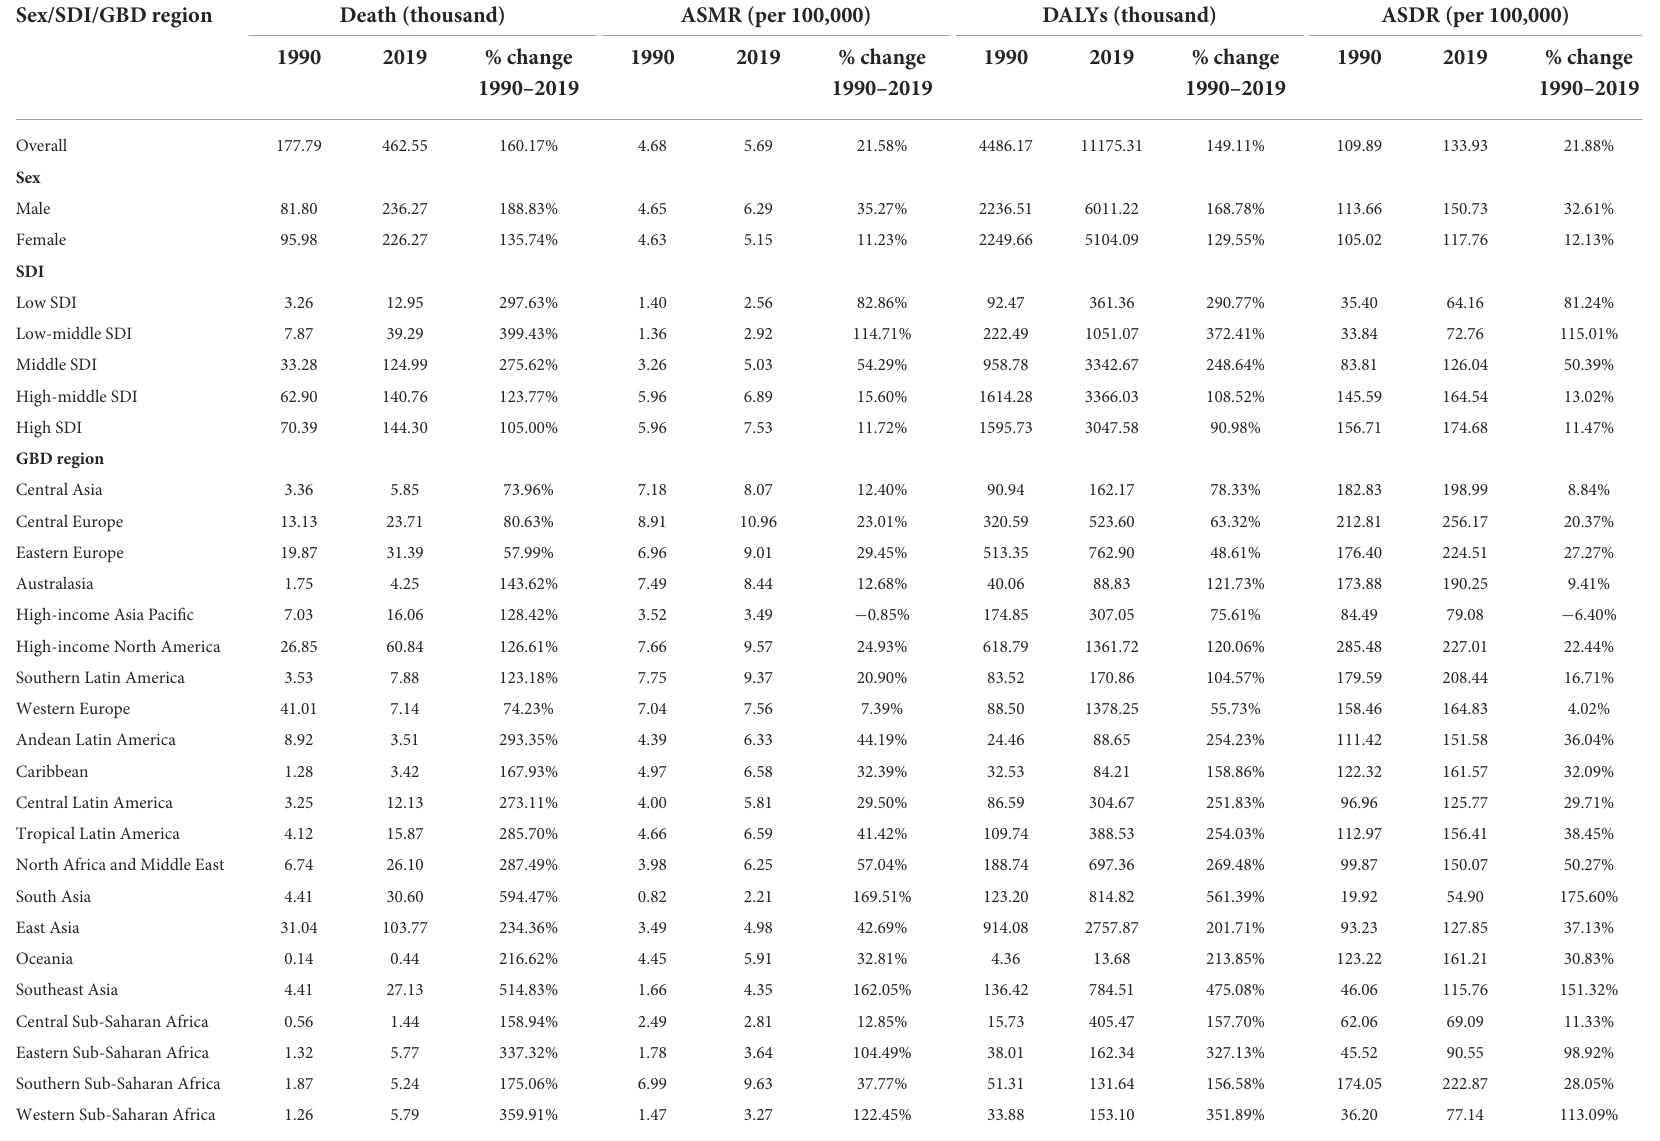
TABLE 1 Global deaths and DALYs of cancer attributable to high body mass index in 2019 and percentage change from 1990 to 2019 by sex, SDI, and GBD region. Sex/SDI/GBD region Death (thousand) ASMR (per 100,000) DALYs (thousand) ASDR (per